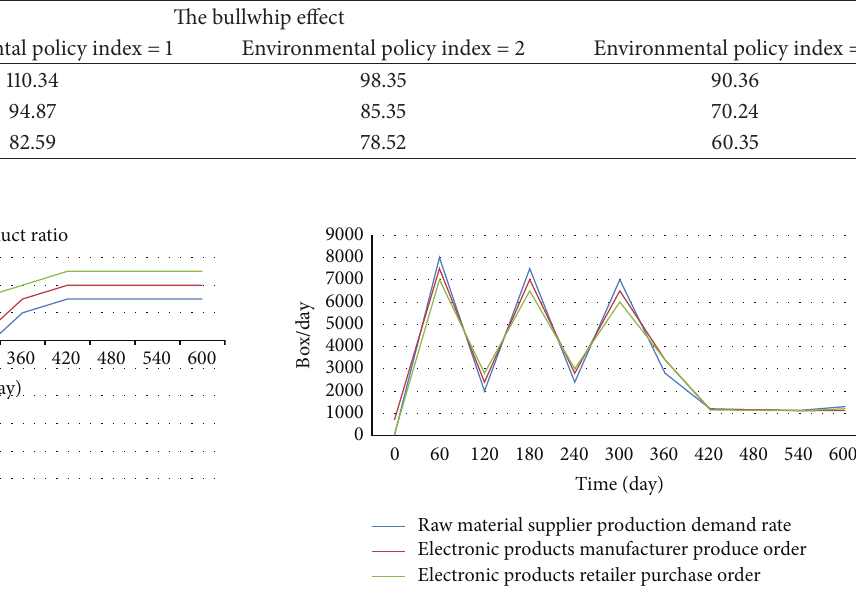
Figure 6: The environmental policy index = 3, the order demand fluctuations in various